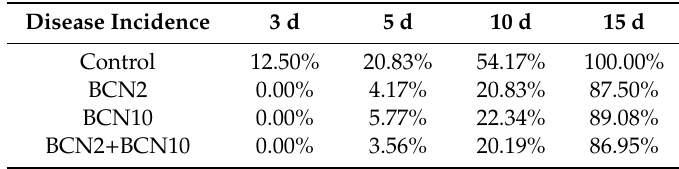
Table 3. Inhibitory e ff ect of volatile organic compounds produced by two Bacillus strains in the natural decay of loquat